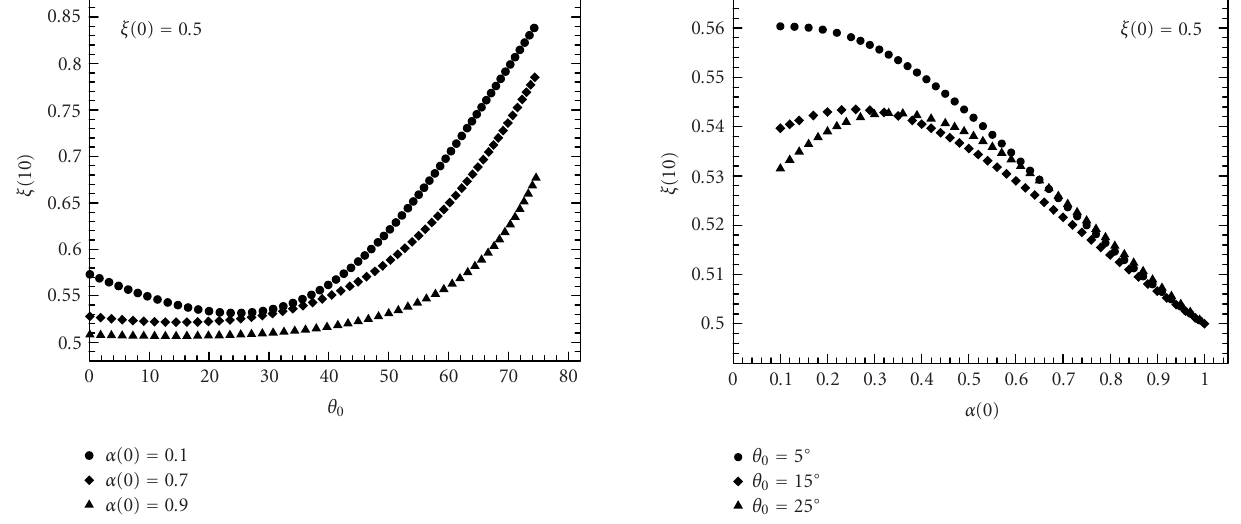
Figure 12: The predicted outlet size of distorted region versus α (0) with higher inlet size of distorted region of 0 .